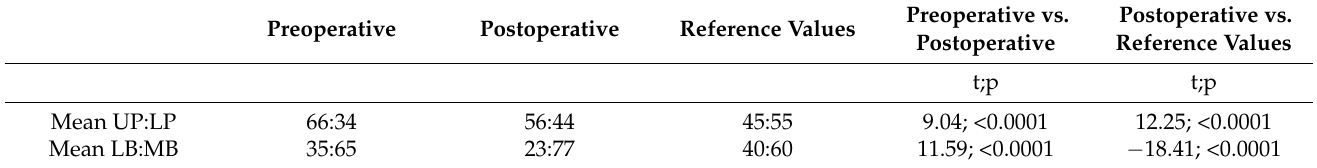
Table 2. Comparison of preoperative and postoperative (6 months after breast reduction) upper pole to lower pole proportions and medial to lateral portions of breasts.